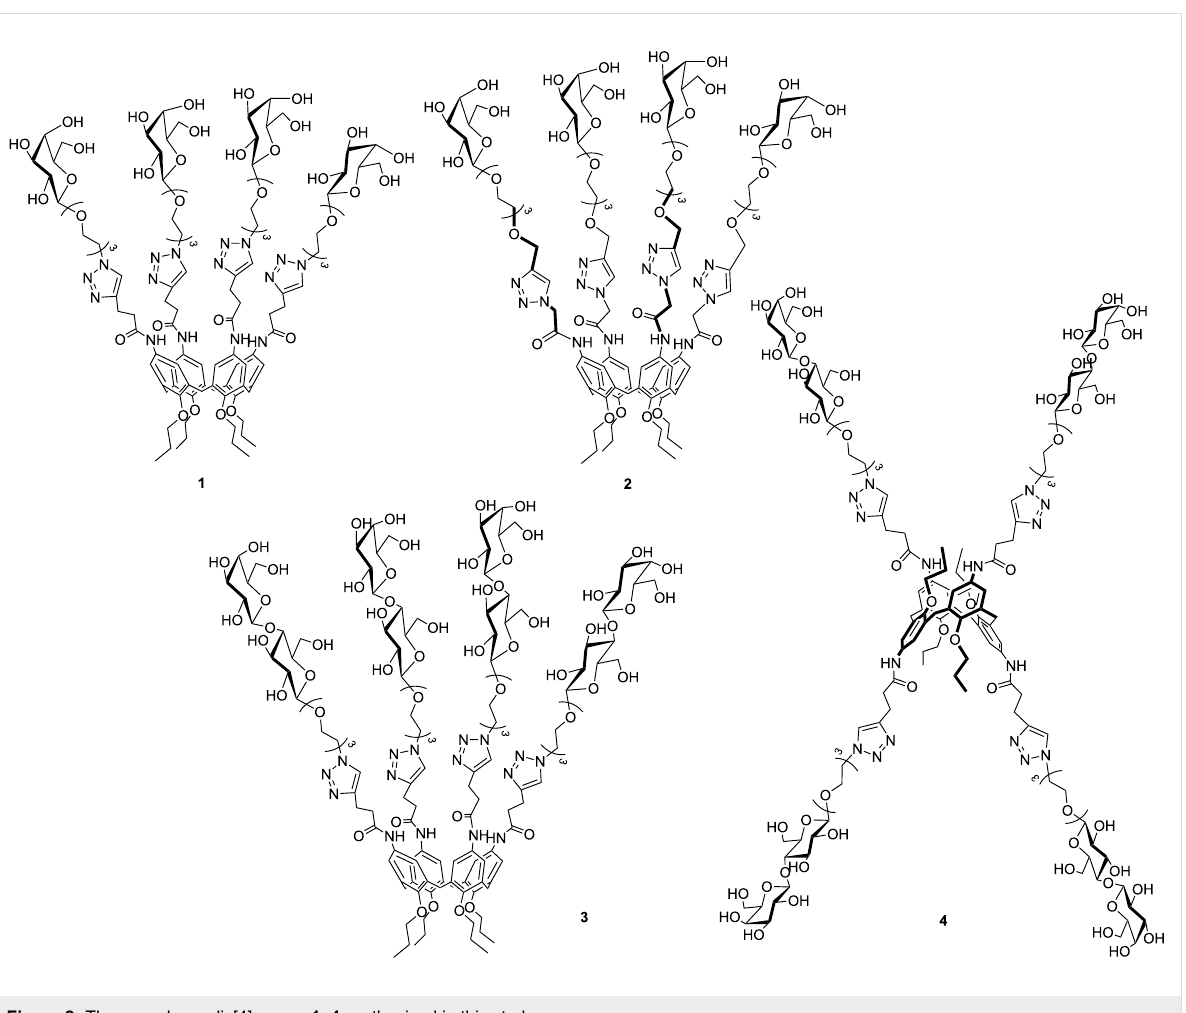
Figure 2: The new glycocalix[4]arenes 1–4 synthesized in this study.